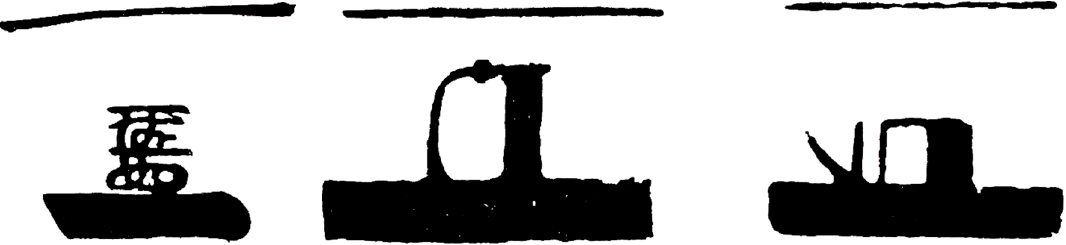
Figure 26. The Song Yuan Huaya with two short lines (A type). The Song Dynasty. Sketched by author. Picture source: Shi (1995), pp. 4, 7.